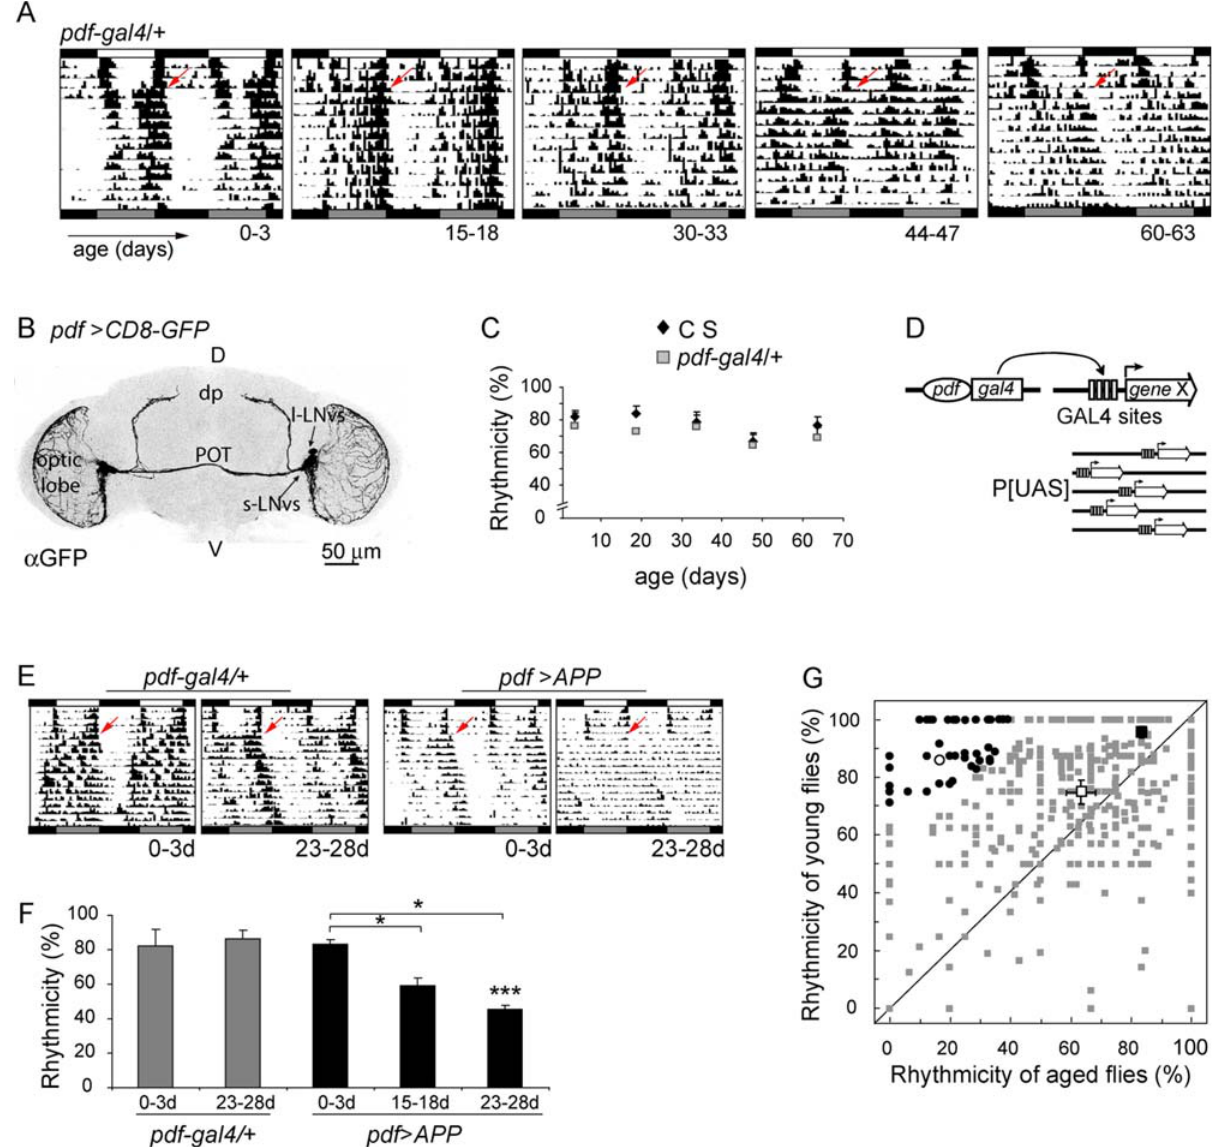
Figure 1. (A–C) Age-related changes in locomotor behavior. Pattern of rest/activity cycles at different times during adulthood evaluated in control lines. (A) Representative double plotted actograms from pdf-gal4/ + flies of increasing age are shown. Each panel depicts the activity of a single fly throughout the experiment. Age at the onset of the experiment is indicated at the bottom of each panel. White, grey and black boxes indicate day, subjective day and night, respectively; arrows represent the transfer to constant darkness (DD). (B) Expression pattern of pdf-gal4 driving a UAS- CD8-GFP reporter gene in the adult brain. GFP recreates the entire PDF circuit. Several relevant landmarks in the adult brain are indicated: small and large LNvs (s-LNvs and l-LNvs, respectively), posterior optic tract (POT), dorsal protocerebrum (dp). (C) Percentage of rhythmic flies for control genotypes (Canton S, CS, and pdf-gal4/ + ). No significant differences were found through the evaluated timescale. Data represent the mean 6 S.E.M. Statistical analysis was performed as described in experimental procedures. Three independent experiments were carried out. Additional details are included in Table S1. (D–G) A misexpression screen in young and aged flies reveals progressive behavioral phenotypes. (D) Schematic diagram of the misexpression screen. The pdf-gal4 line was crossed to a number of independent target P[UAS] lines. In the progeny containing both elements the GAL4 transcription factor binds to the UAS within the P[UAS] transposon, inducing the misexpression of the gene immediately adjacent to it. (E–F) APP overexpression leads to progressive arrhythmicity. (E) Representative double plotted actograms of progressively older pdf . APP and control ( pdf- gal4 / + ) flies. (F) The percentage of rhythmic flies for each strain is shown. Aged pdf . APP flies show decreased rhythmicity, which is significantly different from aged controls (***), and its younger counterparts (*) . (* p , 0.05 and *** p , 0.001). Three independent experiments including forty to seventy flies were carried out. (G) A direct comparison of rhythmicity for each misexpressed line in young and old flies. Misexpression of most P[UAS] lines do not result in a progressive phenotype ( & ). Each dot represents the average rhythmicity for a certain insertion line tested at a young and older age. Flies that were highly rhythmic when young but whose rhythmicity decreased severely as they aged were considered as potential neurodegenerative mutants and further retested (indicated by N ). This was the case with P[UAS] 117 ( # ). Control flies such as pdf-gal4/ + ( % ) and pdf- gal4 , UAS- CD8-GFP/ ++ ( & ) describe the behavior of the majority of the lines tested ( & ).